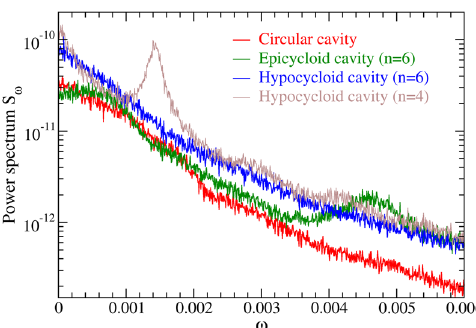
Fig. 4 Power spectrum for time variation of defect density in closed cavities. Power spectrum S ω of the defect number density for circular, 6-cusp epicycloid, and 4- and 6-cusp hypocycloid cavities at v 0 = 0.31, each averaged over 80 simulations for t = 10 5 − 10 6